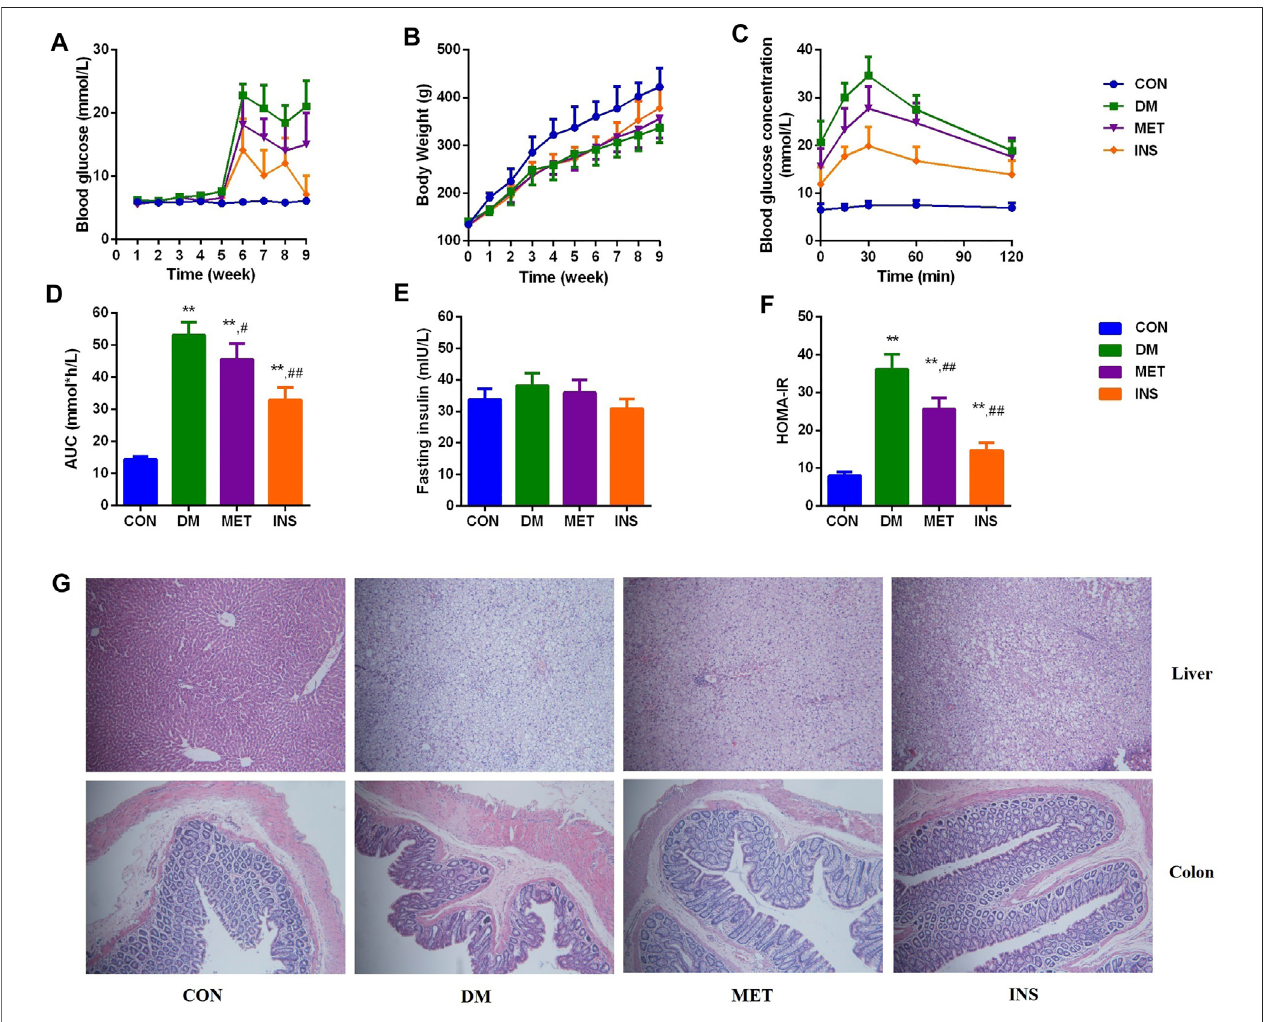
FIGURE 1 | Effects of metformin and insulin on (A) Blood glucose; (B) Body weight; (C) Oral glucose tolerance test (OGTT); (D) Area under the curve (AUC) of OGTT; (E) Fastinginsulin; (F) HOMA-IRindex; (G) Histologicalstructureofliverandcolon(HEstaining)* p < 0.05,** p < 0.01vs.CONgroup.# p < 0.05,## p < 0.01vs.DM